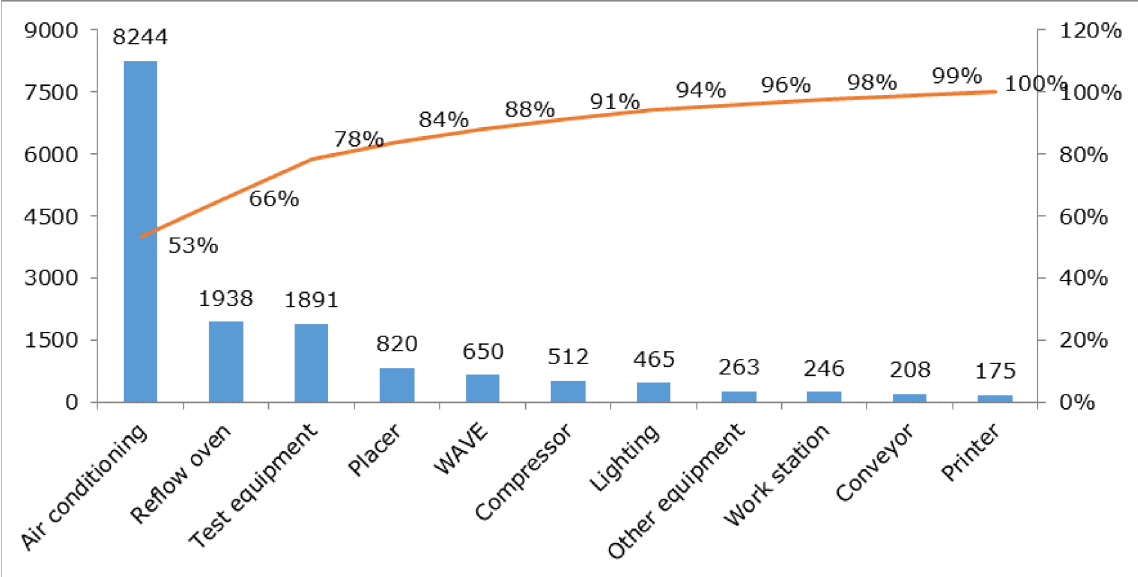
Figure 7. Pareto Chart for Alpha Power